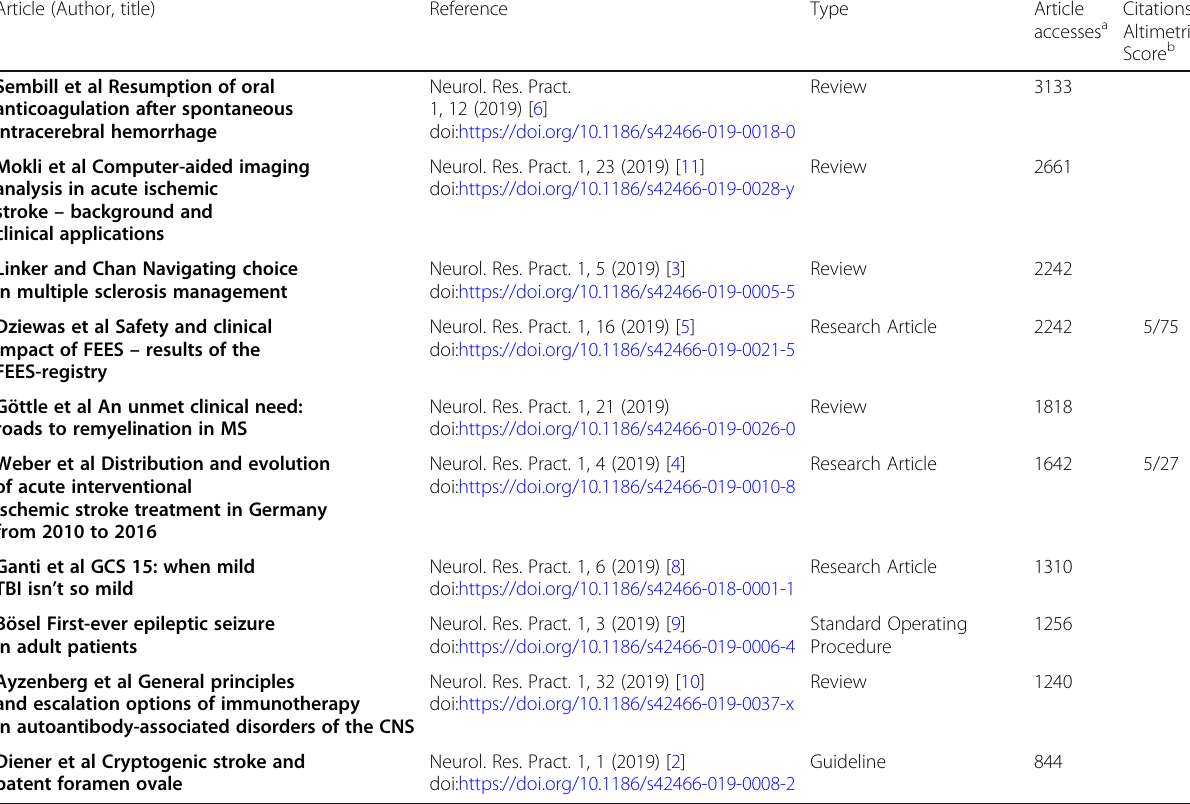
Table 1 Articles with highest access rates and